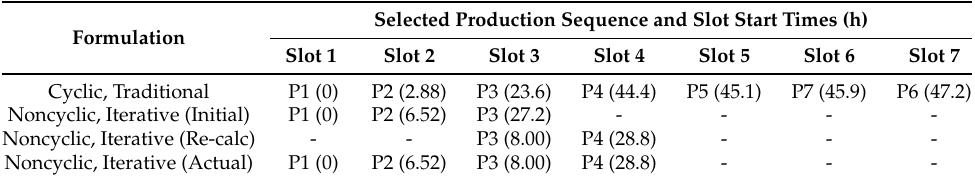
Table 27. Production schedule: Scenario 5.